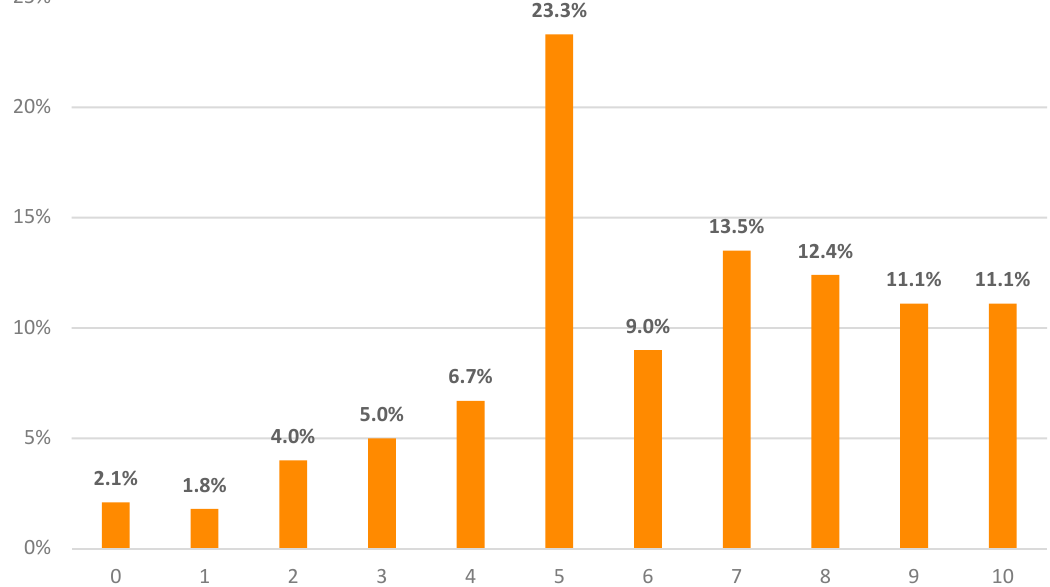
Figure 5. Self-assessment of the improvement in ability to access RSD as a result of participation in the ARSET program. Values indicate the percentage of respondents who selected each option. In the 11-point scale used, 0 = did not change, and 10 = improved a great deal ( N = 920).